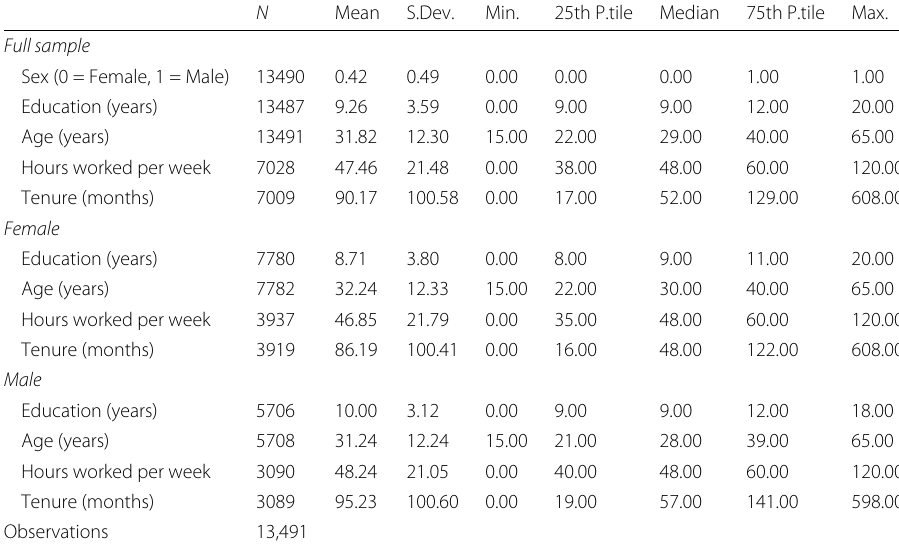
Table 8 Summary